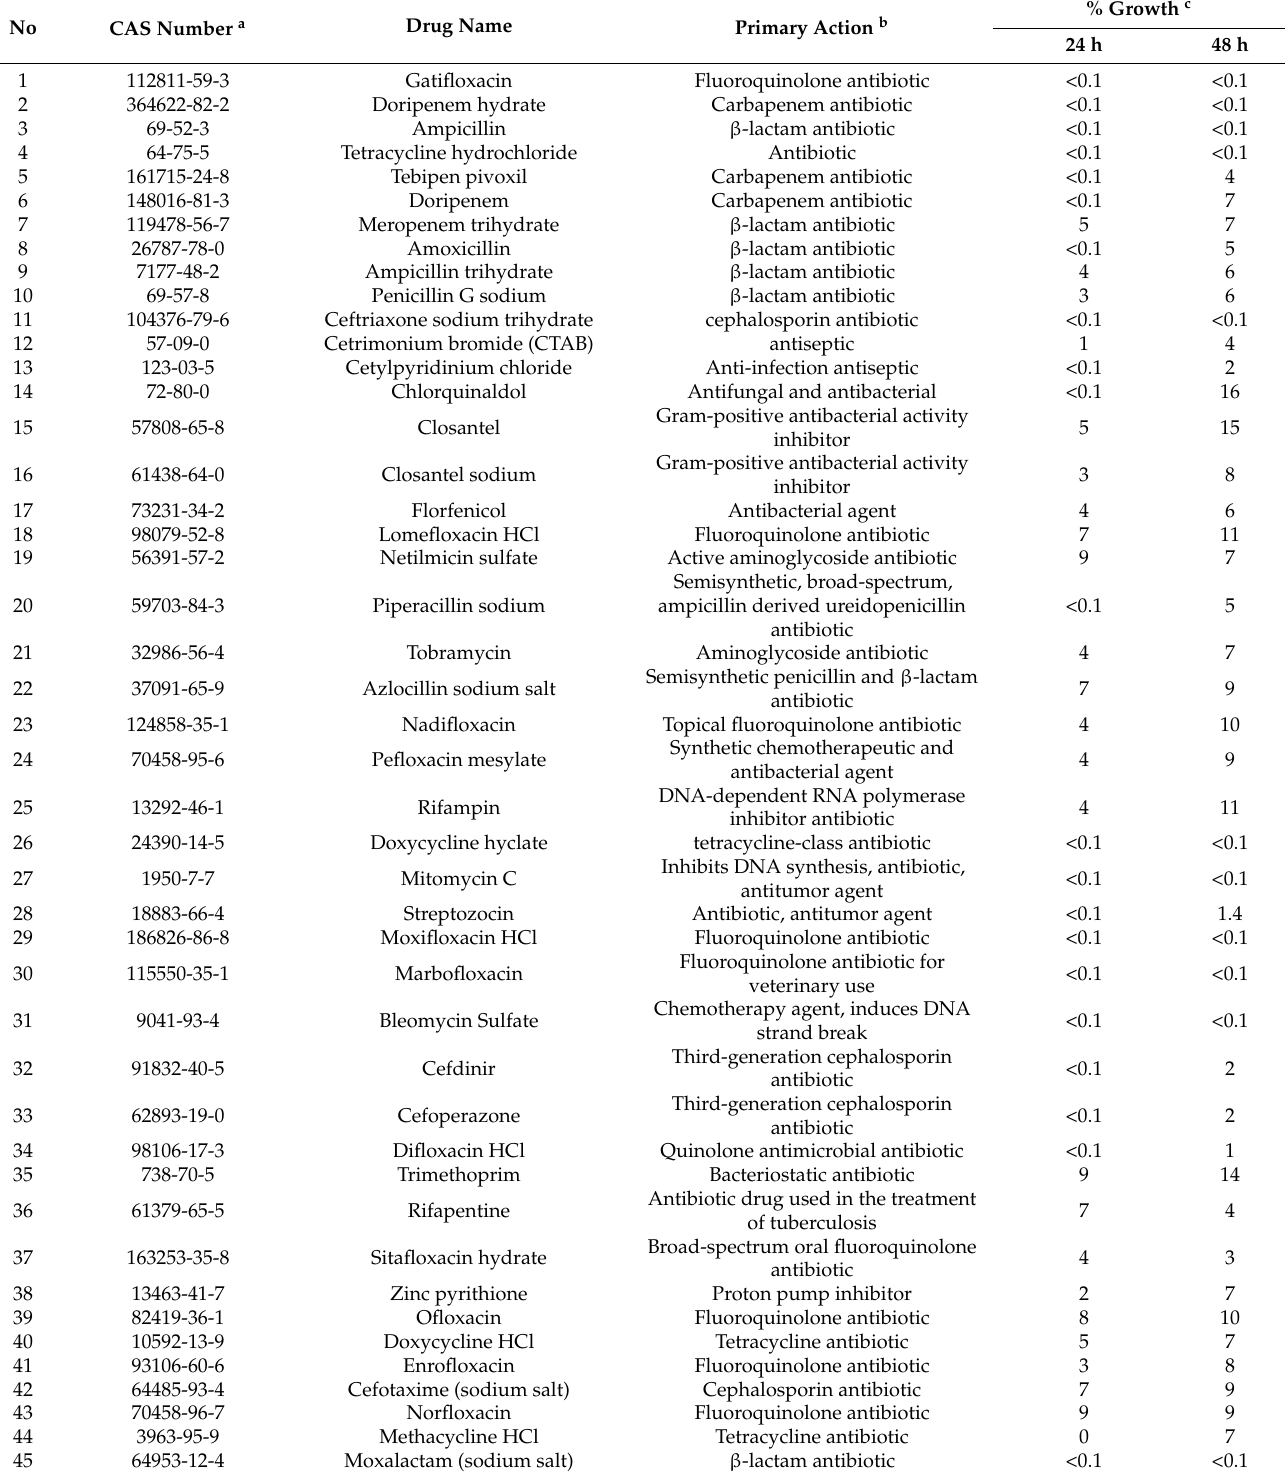
Table 1. Compounds inhibiting Y. pestis